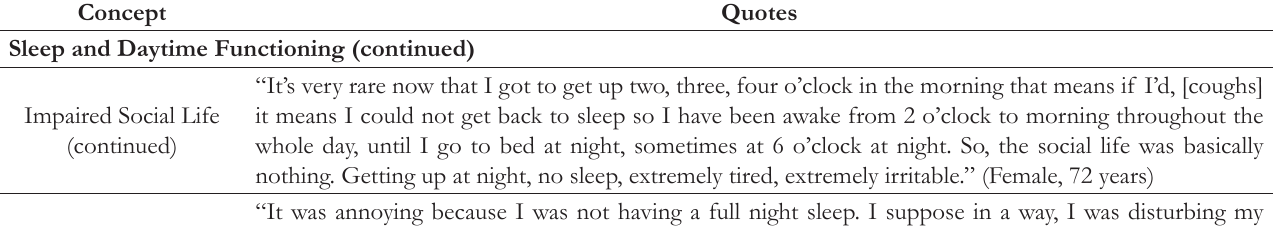
Table 2. Concepts and Illustrative Quotes Pertaining to Those Concepts - continued